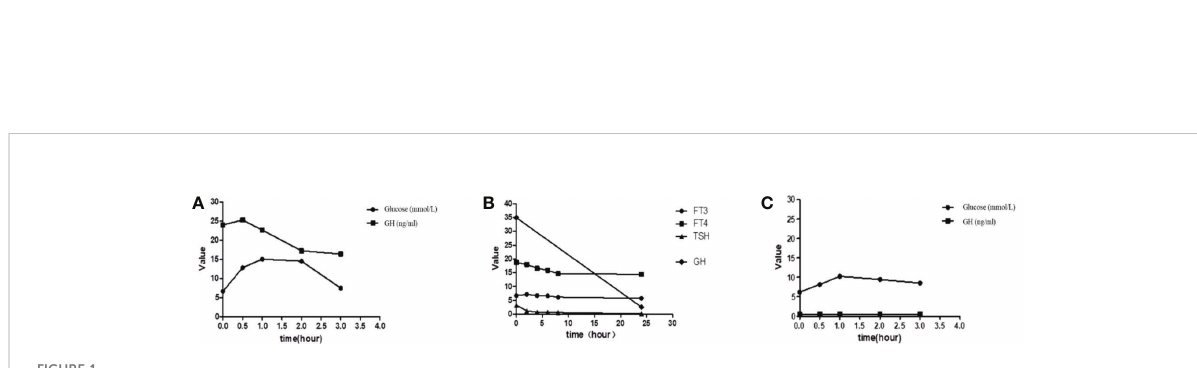
Reference range